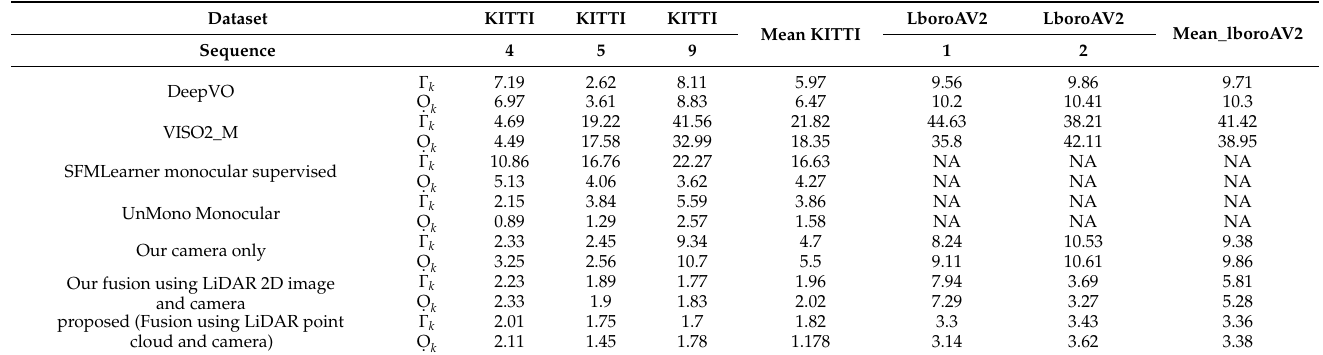
Table 1. Comparison of RMSE between the proposed method and benchmarking approaches.